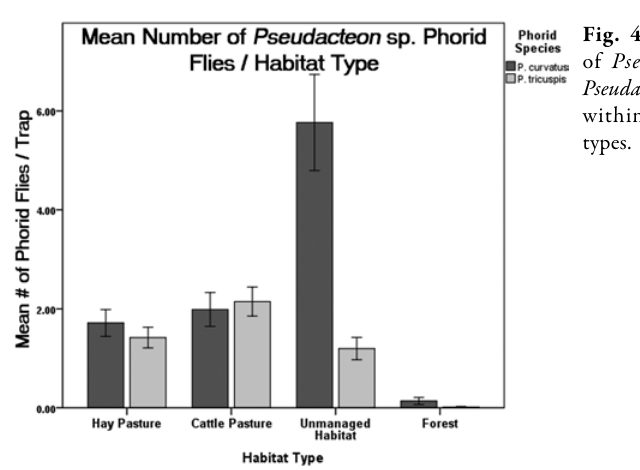
Fig. 4. Relative abundance of Pseudacteon curvatus and Pseudacteon tricuspis across and within each of four habitat